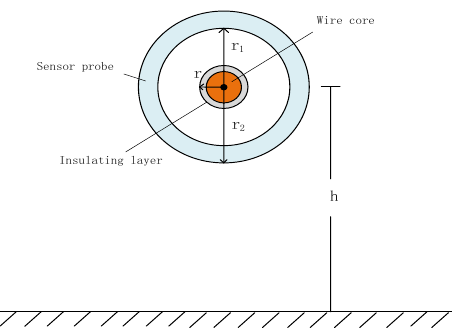
Figure 2. Cross-section of ideal coaxial sensor on transmission